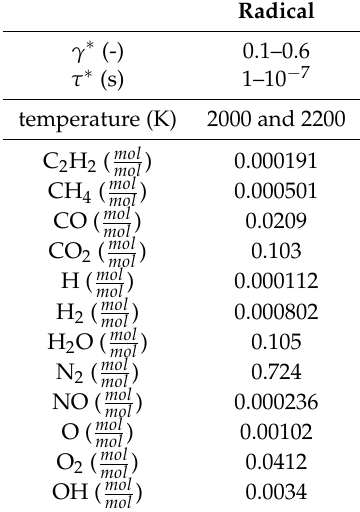
Table 2. Initial values for the simple PSR versus PFR fine structure treatment radical species test